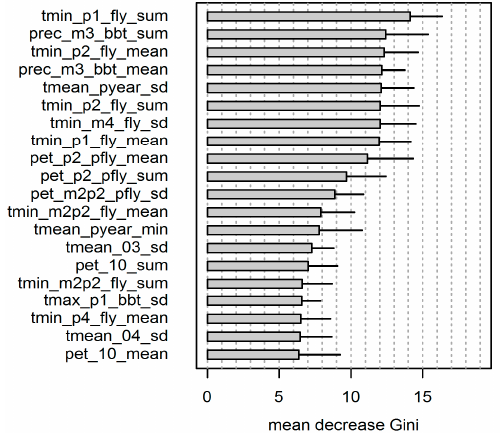
Figure 8. Variable importance based on a 10-fold cross-validation of the Random Forest and the “mean